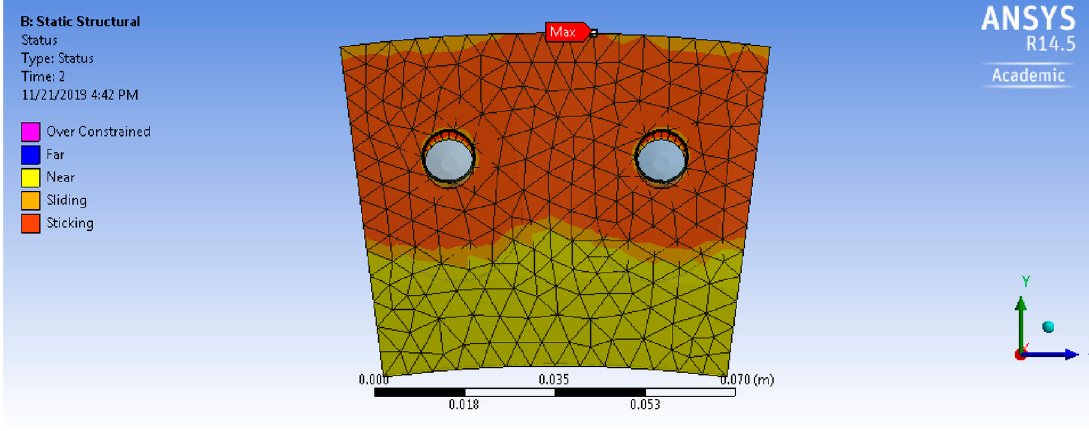
Figure 13. The complex flanges gliding atop and around the